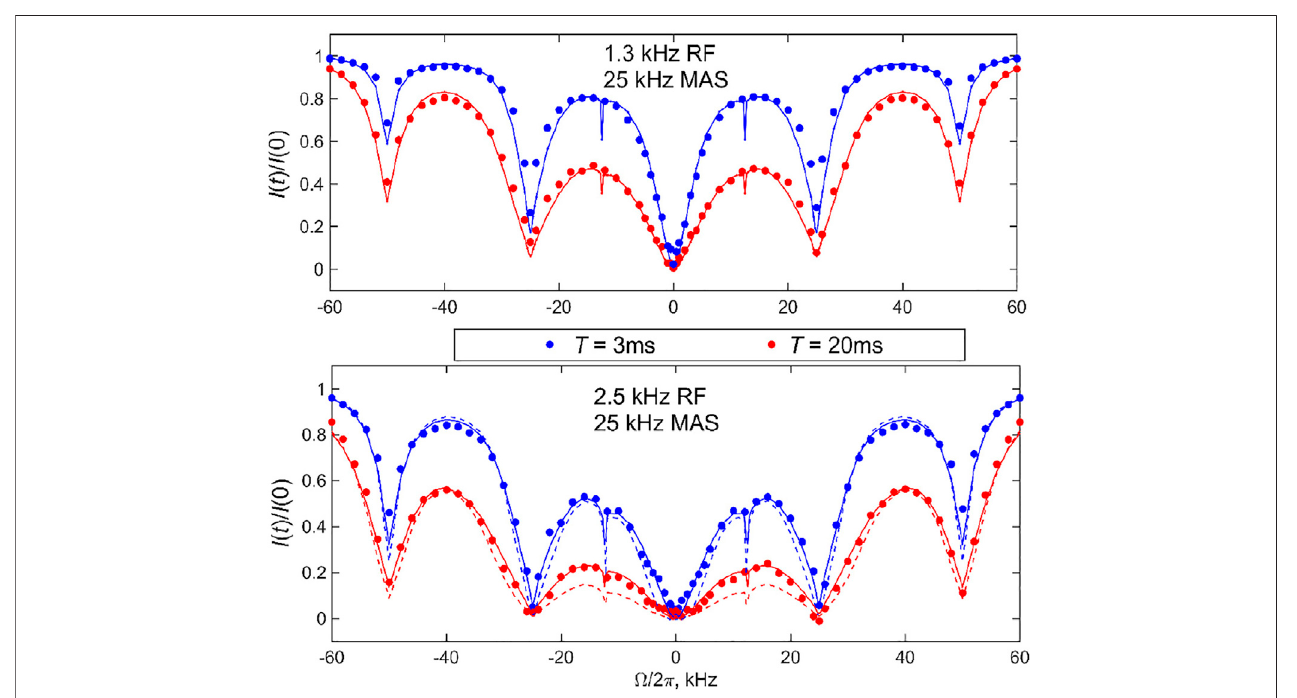
FIGURE 8 | 2 H CEST center band pro fi les for DMS at the 25 kHz MAS rate. Experimental normalized integrated central band intensities I ( t )/ I (0) versus resonance offsets Ω / 2 π forsaturation fi eldsof1.3 kHz(upperpanel)and2.5 kHz(lowerpanel)andsaturationtimesof T (cid:2) 3 ms(bluecircles)and T (cid:2) 20 ms(redcircles)at17.6Tand 76 ° C. The solid lines represent the best fi t to the data, corresponding to k fl ip (cid:2) 9,000 s − 1 for ω RF / 2 π (cid:2) 1.3 kHz and k fl ip (cid:2) 10,000 s − 1 for ω RF / 2 π (cid:2) 2.5 kHz. The k 3 value was fi xed at 4.9 · 10 9 s − 1 .The effect ofRF inhomogeneity withtheinhomogeneity pro fi lesof Figure 1B wasincluded asdescribedinthetext. The dotted lines inthe bottom panel show the simulations in the absence of RF inhomogeneity.